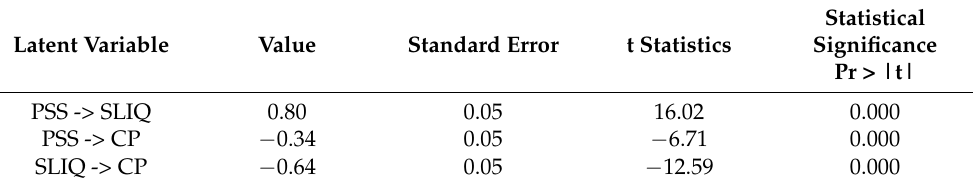
Table 7. Findings from the mediation analysis between stress, concentration performance, and lifestyle among participants during the